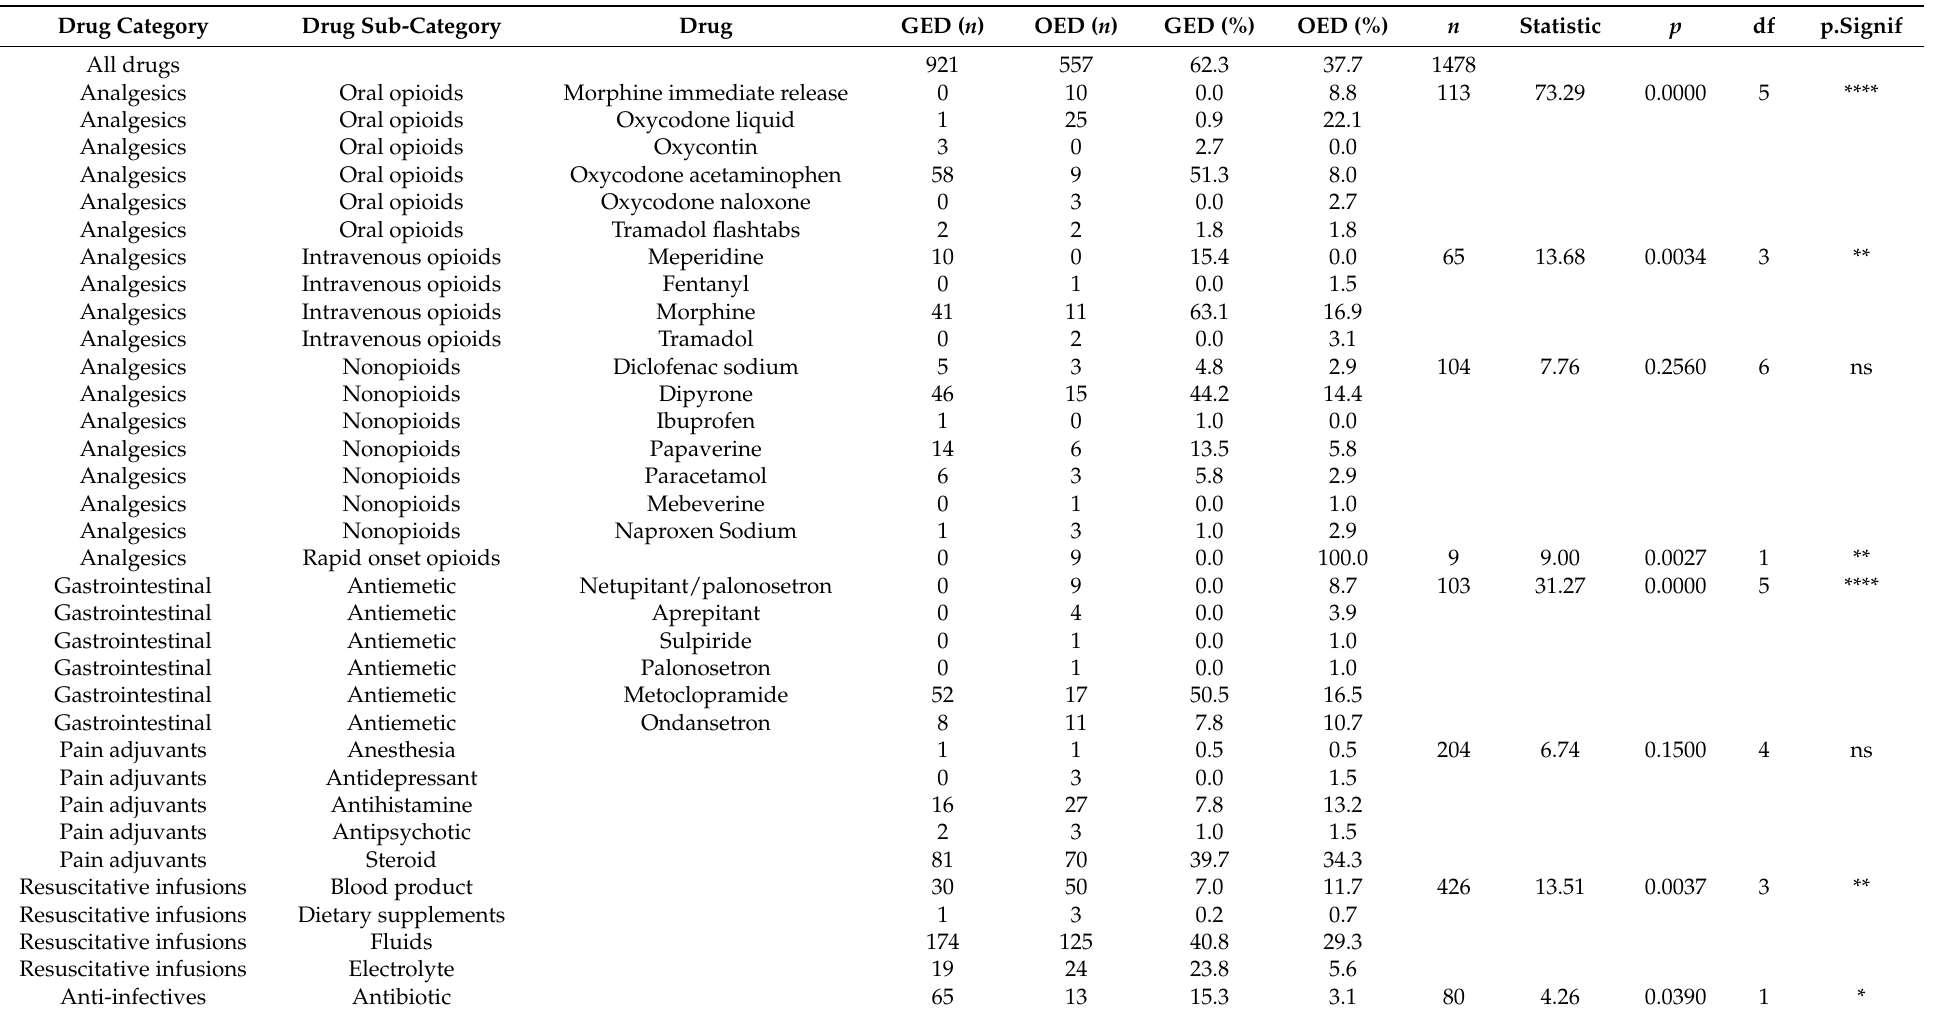
Table 2. Administration of drugs in the emergency settings: general emergency department (GED) vs. oncology emergency department